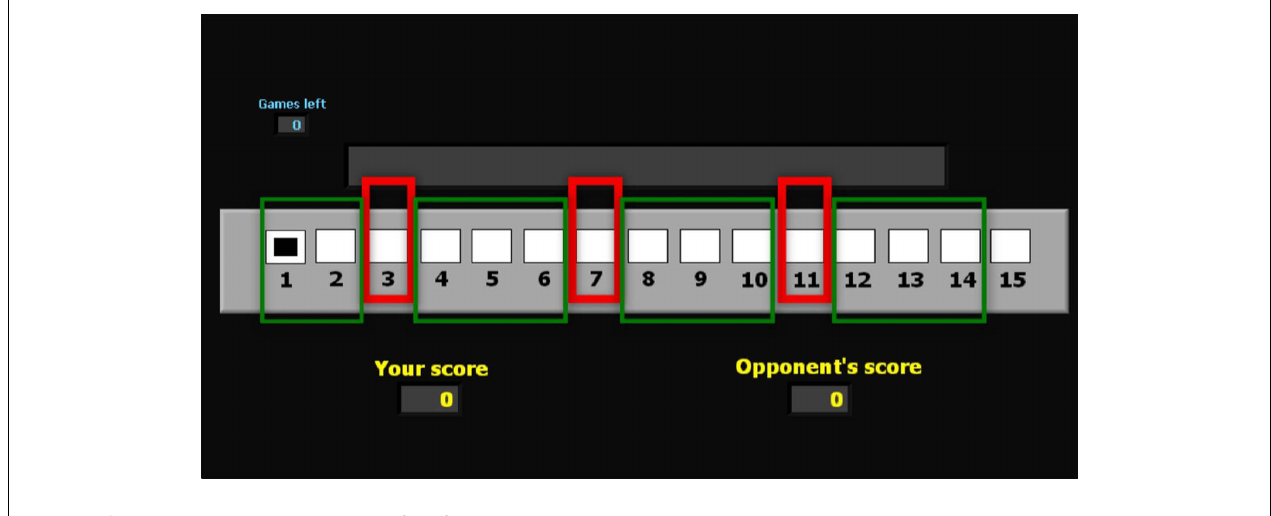
FIGURE 1 | Board of positions for the game G (15, 3). This is the board of positions used in the imaging experiment.The superimposed red rectangles indicate the losing positions 3, 7, and 11.The green rectangles